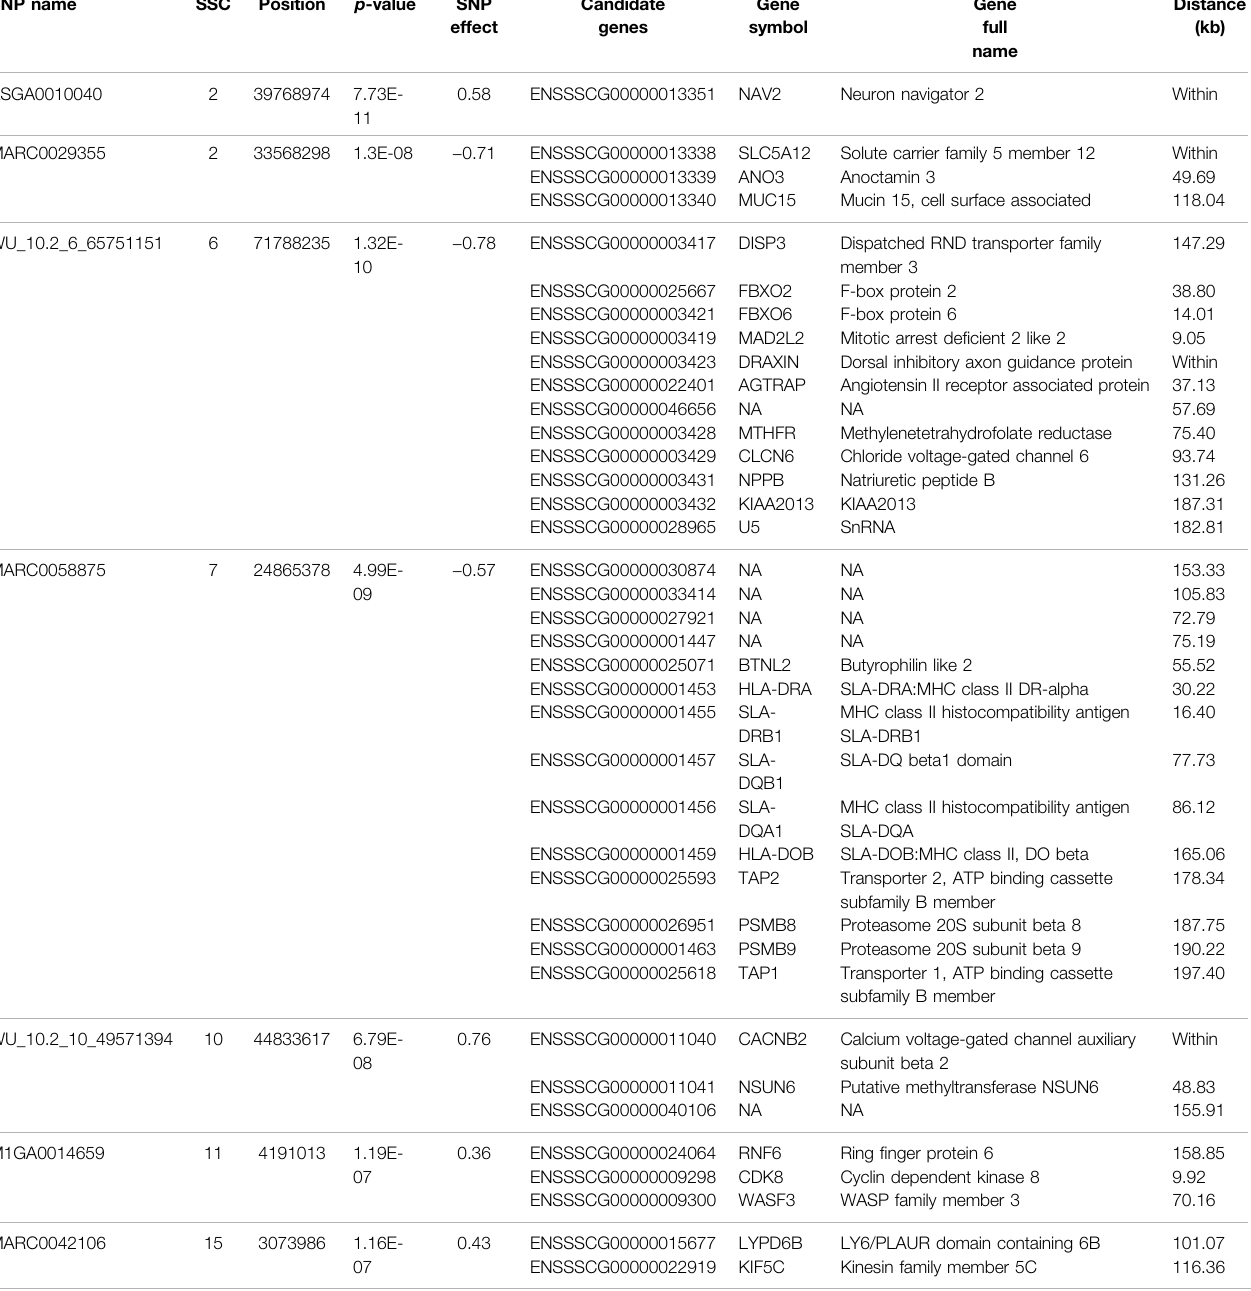
TABLE 1 | Candidate genes associated with milk production ability by genome-wide association